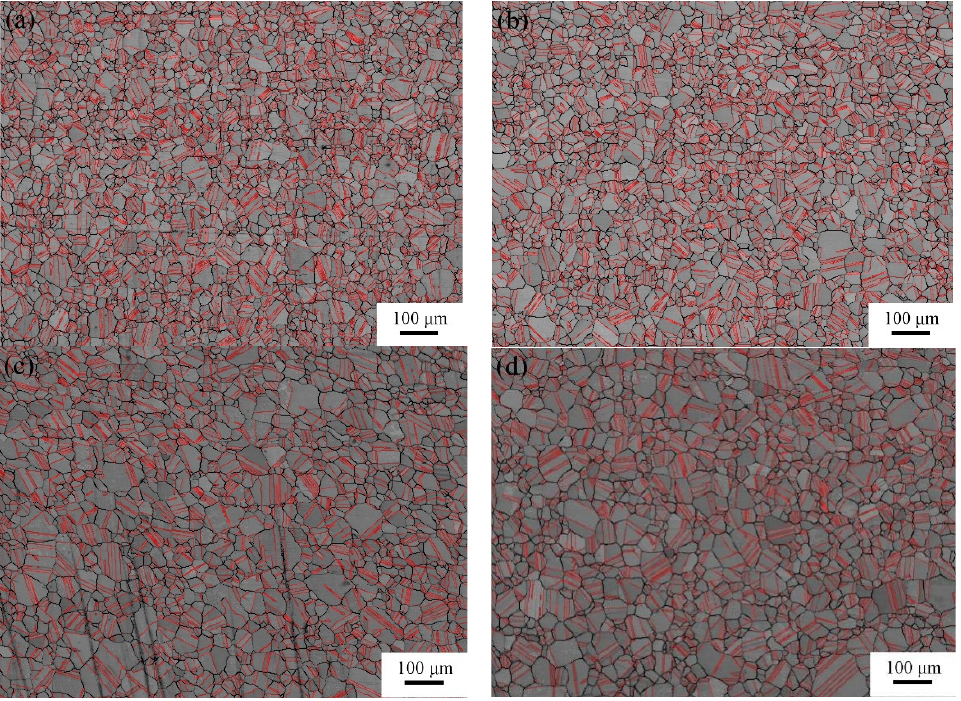
Figure 5. Grain and grain boundary network of Ni-36.6W-15Co after annealing for ( a ) 10 min, ( b ) 30 min, ( c ) 60 min and ( d ) 120 min at 1150 °C.